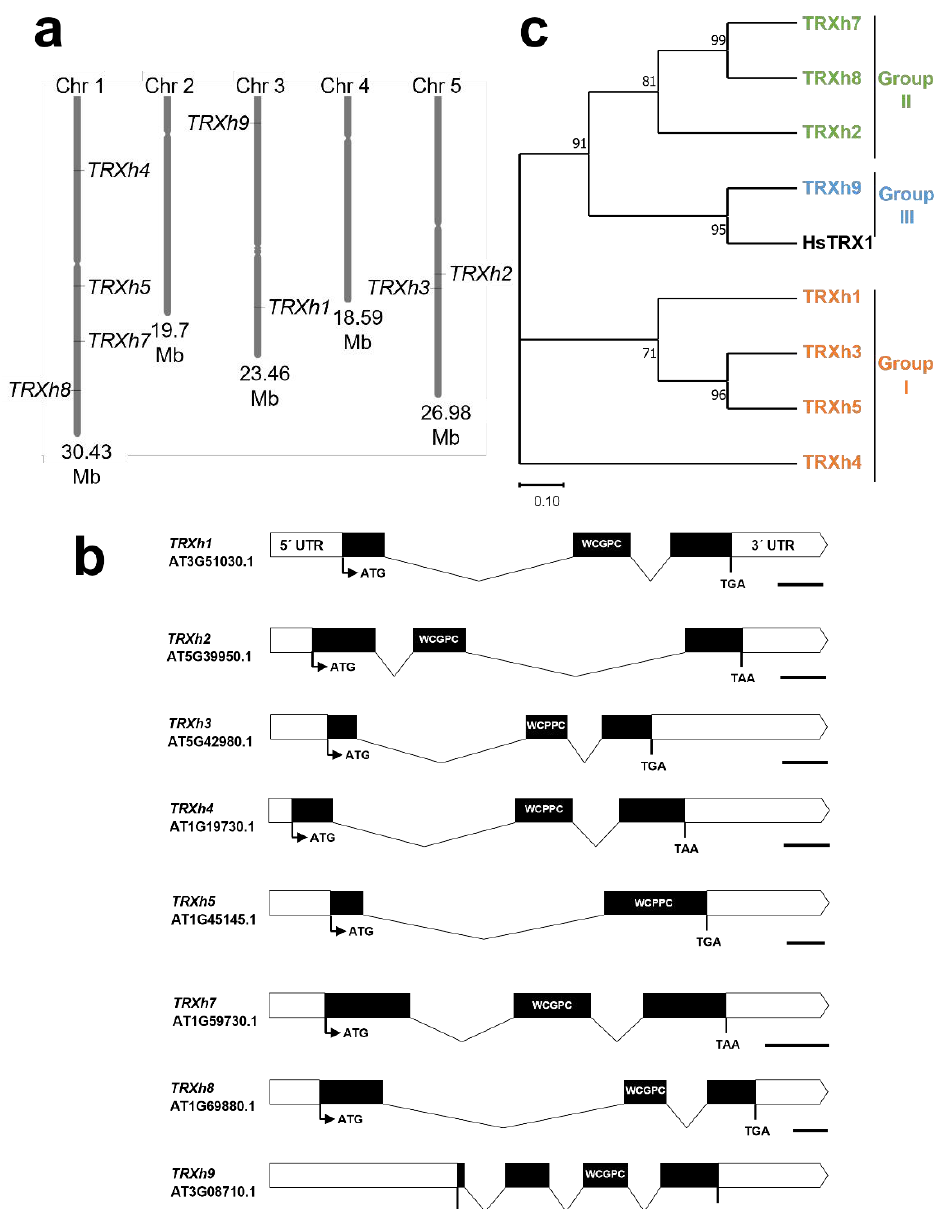
Figure 2. Chromosomal location, gene structure and phylogenetic relationships of h-type thioredoxins from Arabidopsis . ( a ) Chromosomal location of h-type TRXs from Arabidopsis . ( b ) Intron-exon structure of representative gene models. Exons are represented by black bars and introns by folded black lines, while 5 ′ - and 3 ′ UTR regions are white boxes. Lines and bars to scale and represent total sequence length. ATG; start codon, TGA/TAA; stop codon, WCG/PPC; active site. Scale bars represent 100 nucleotides. ( c ) Maximum likelihood phylogenies for h-type TRX proteins from Arabidopsis and TRX1 from Homo sapiens . Protein sequences from representative gene models were used with the MEGA 11 program with bootstrap test (1000 times) and neighbor-joining method. Branch lengths are proportional to phylogenetic distances.